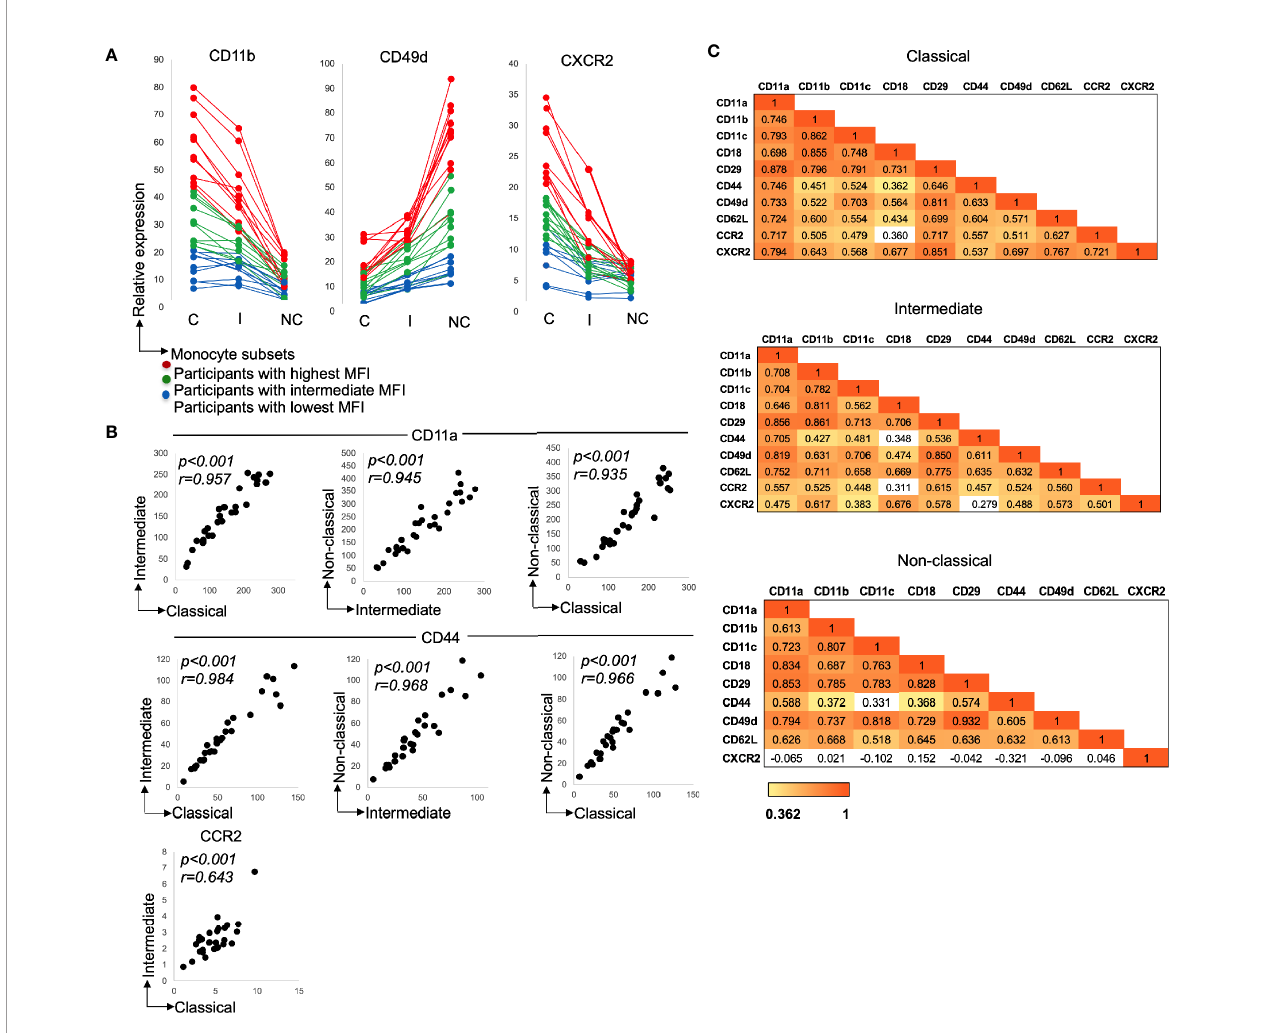
FIGURE 2 | (A) Variation in adhesion marker expression between the participants and monocyte subsets. Monocyte subset adhesion molecules, CD11b, CD49d (integrins) and chemokine receptor, CXCR2 expression. Each line on the graph is representative of relative adhesion marker expression from one participant. Participants with the highest marker expression were ranked based on monocyte subsets expressing the highest, CD11b, CD49d, and CXCR2. Red lines show participants with highest CD11b, CD49d, and CXCR2 expression (n = 10), green lines show participants with intermediate CD11b, CD49d, and CXCR2 expression (n=10) and blue lines show participants with lowest geometic mean fl uoroscence intensity (MFI), CD11b, CD49d, and CXCR2 expression (n=10). C: Classical; I: intermediate and NC: non- classical. (B) Relationship between adhesion molecule expression by the monocyte subsets. Expression of CD11a (all p < 0.001 ; n=30), CD44 (all p < 0.001 ; n=30) and CCR2 (C- p < 0.001 ; n = 30). Data presented as scatter plots. The statistical signi fi cance of correlation was determined by Spearman ’ s rank correlation. All tests were two tailed. r represents correlation coef fi cient and p represents the statistical signi fi cant value. (C) Heatmap with correlation matrix. Panel 1: Classical monocytes, 2: Intermediate monocytes and 3: Non-classical monocytes. For all heatmaps, values are Spearman ’ s rank correlation coef fi cients. The color in the heatmap represents the degree of correlation. Red (value of 1) represents a stronger correlation coef fi cient and more signi fi cant p value. Yellow (value of 0.362) represents a moderate correlation coef fi cient and p value of 0.05 or less. White boxes represent non-signi fi cant